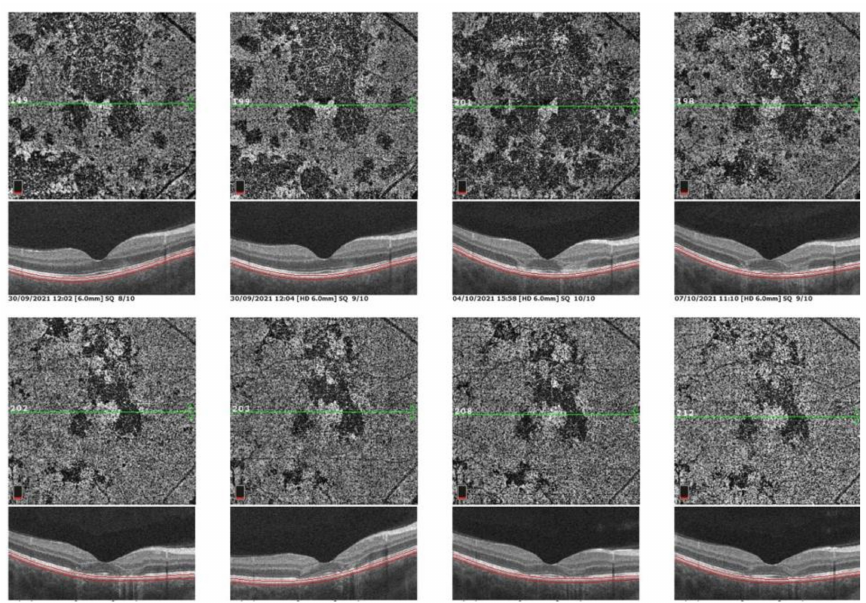
Figure 12. Sequence of OCT-A frames from presentation to convalescent stage. OCT-A 6 × 6 en face scan of the posterior pole OD choriocapillaris showing progressive resolution from the first scan ( top left ) to last scan ( bottom right ). Dark areas of non-perfusion were partly